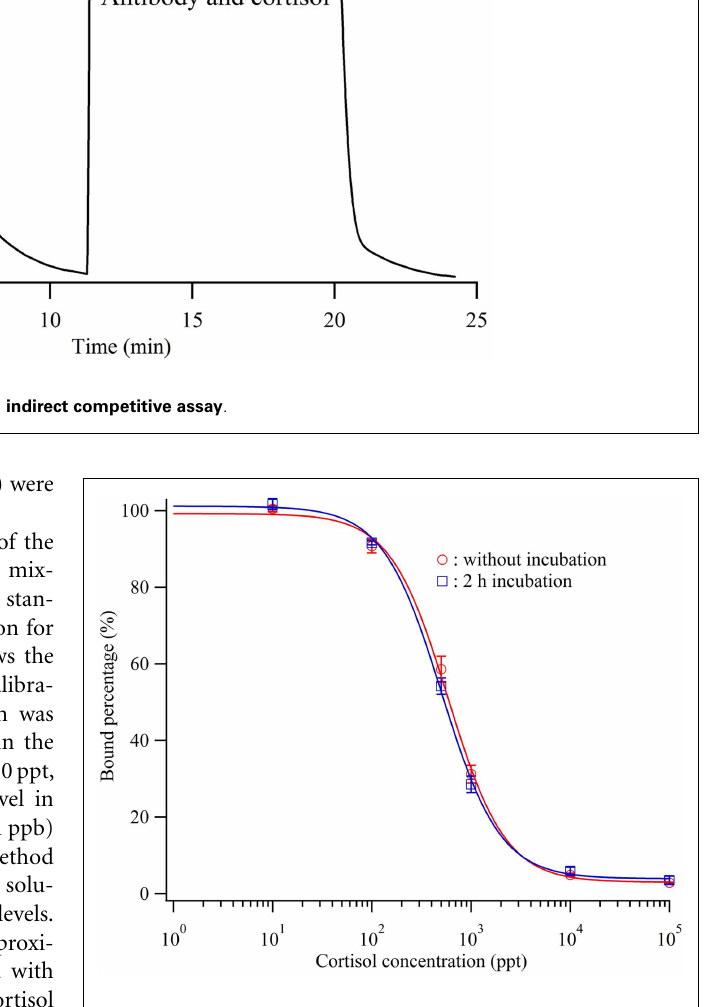
FIGURE 3 | Calibration curve of the cortisol biosensor with or without incubation before injection of cortisol standard cortisol and cortisol antibody . ; without incubation, ; 2h